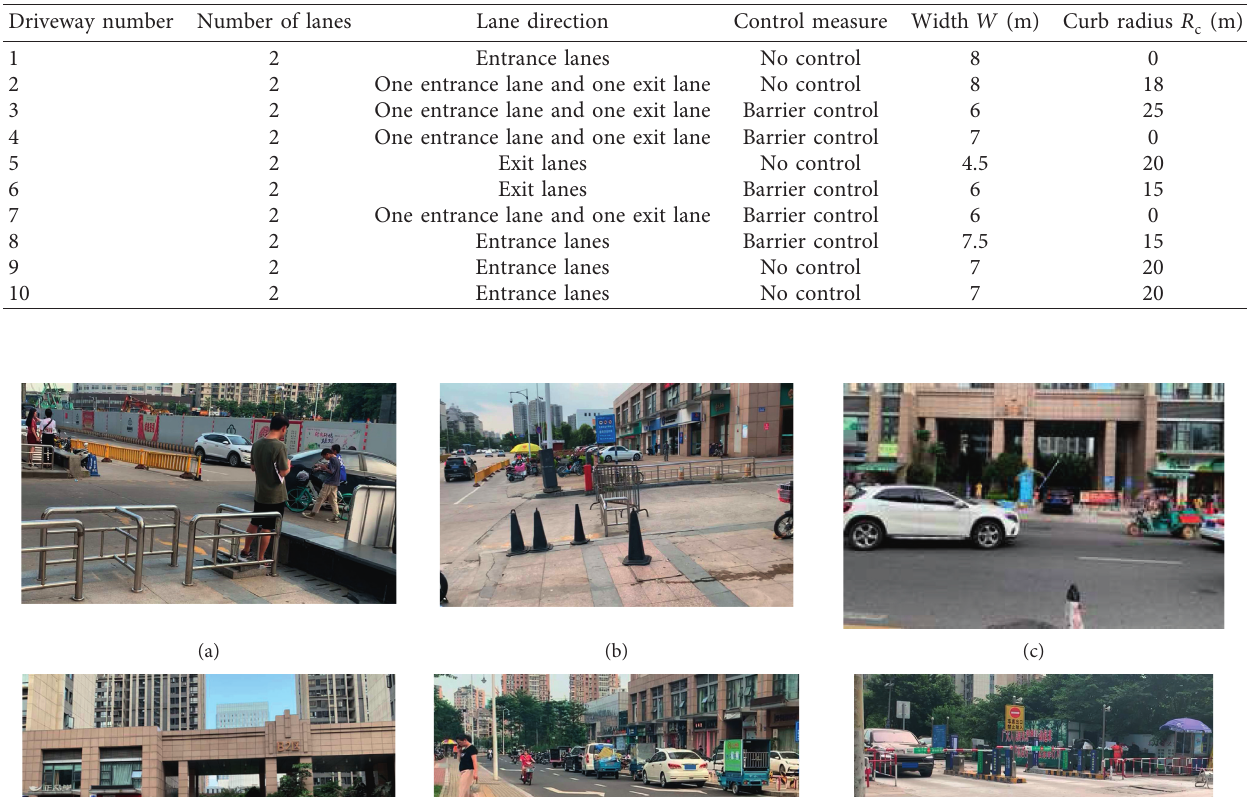
Table 3: Current design of driveways.